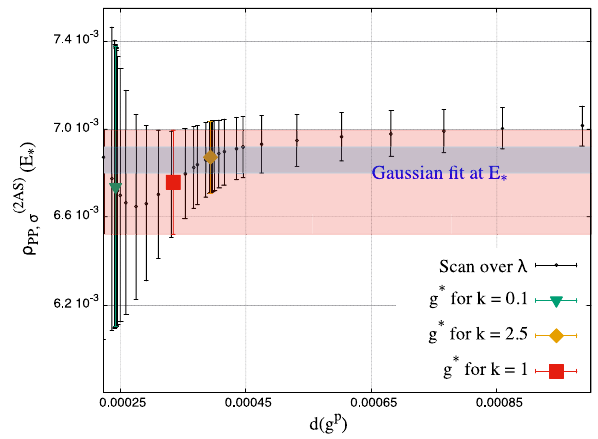
Fig. 12 The plot updates Fig. 7, which shows that the reconstruction (red band) does not change outside the statistical error (black bars) for different choices of the unphysical parameter λ, in the given range of d ( g p ) (cf. Equation (63)). The blue band is the fit result of the smeared spectral density to a sum of Gaussians at the point E (cid:24) . Encouragingly, the fit is compatible with all points in the scan, showing that stability in the reconstruction translates into stability for the